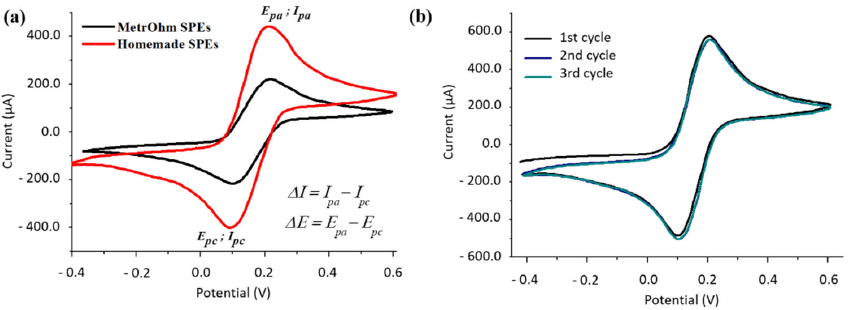
Figure 7. ( a ) CV diagrams of homemade and commercial microsensors; ( b ) 3 consecutive CV curves recorded during the stabilization of the sensor response; measurements were made in the [ − 0.4 V; +0.6 V] range at a scan rate of 100 mV/s and using a solution of 10 mM of Fe 3+ /Fe 2+ redox couple in TBS.